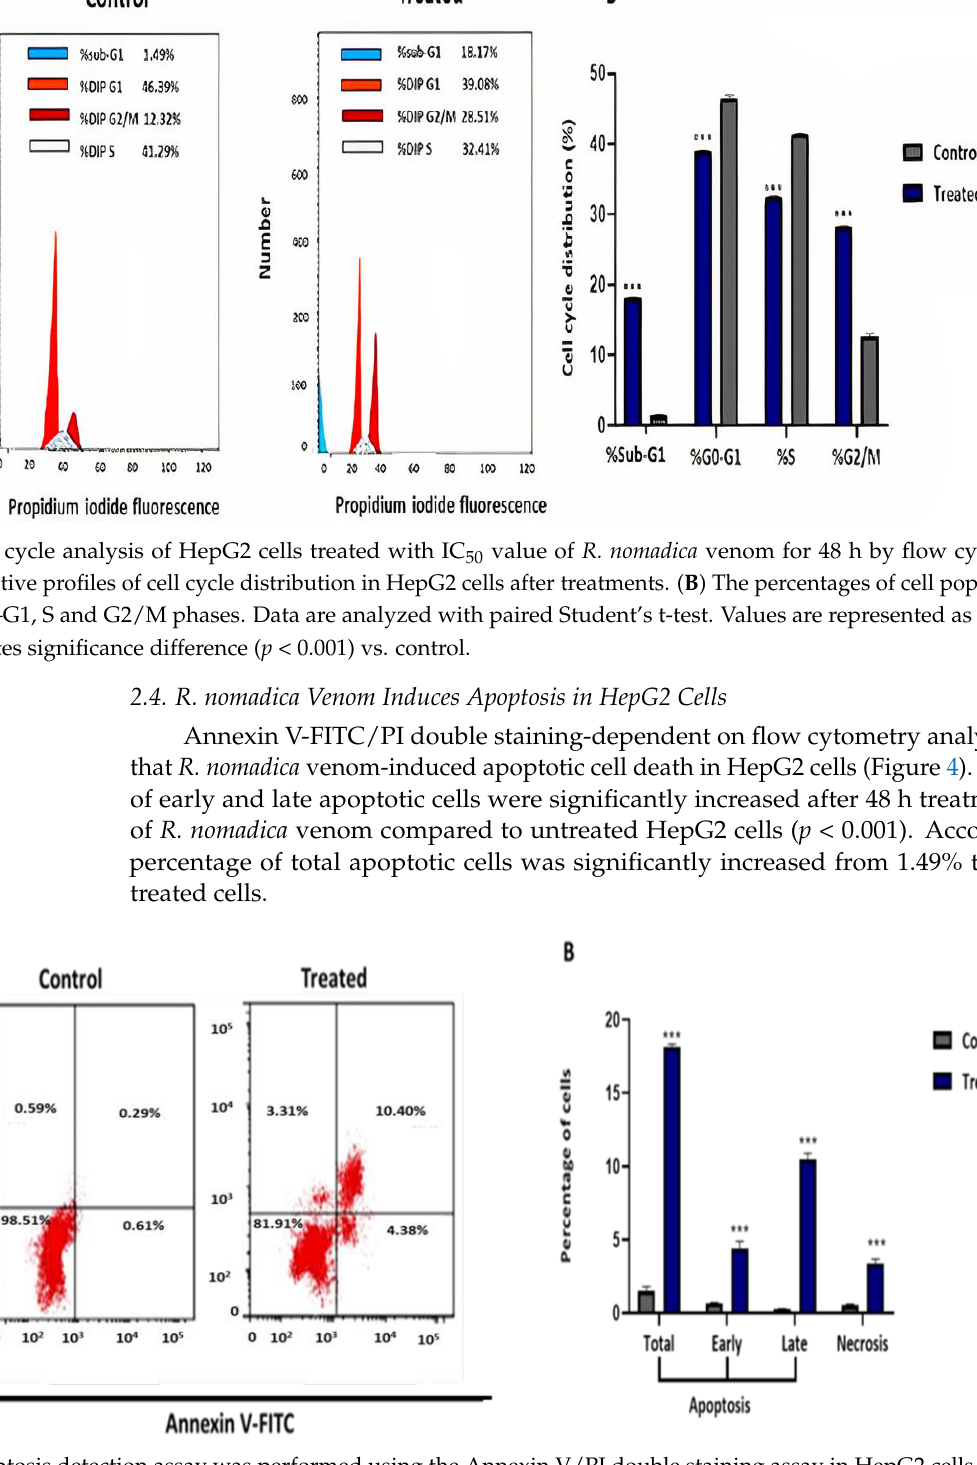
Figure 4. Apoptosis detection assay was performed using the Annexin V/PI double staining assay in HepG2 cells. HepG2 cells were treated with IC 50 value of R. nomadica venom for 48 h, stained with Annexin V and PI, and analyzed on BD FACSCalibur flow cytometer. ( A ) Representative scatter plots of PI ( y -axis) vs. Annexin V ( x -axis). Lower left quadrants show viable cells (An −, PI −), whereas lower right quadrants represent the early apoptotic cells (An +, PI −). The upper left quadrants contain the necrotic cells (An −, PI +), while the upper right quadrants demonstrate the late apoptotic cells (An +, PI +). ( B ) Quantification graph of Annexin V/PI double staining assay obtained from BD FACSCalibur flow cytometer. Data are analyzed with paired Student’s t-test. Values are represented as mean ± SEM. *** denotes significance difference ( p < 0.001) vs.